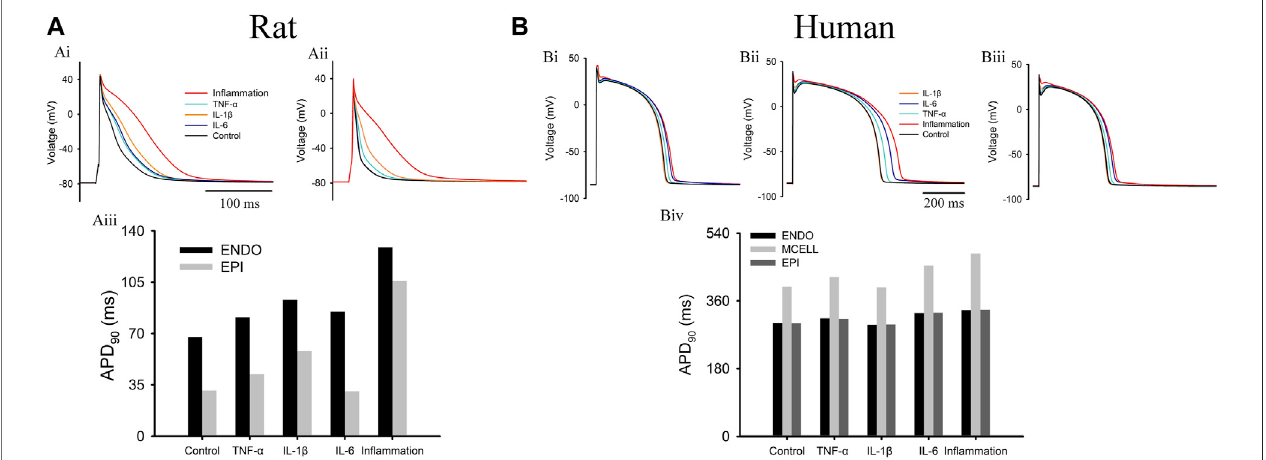
FIGURE 1 | Effects of different in fl ammatory cytokines on action potentials in (A) rat and (B) human models. Top panels plot the APs in (Ai) rat ENDO (Aii) rat EPI, (Bi) human ENDO, (Bii) human MID, and (Biii) human EPI cells. The bottom panels are the APD 90 of different cells for (Aiii) rats and (Biv) humans. Note: “ in fl ammation ” represents the combined effects of three cytokines.